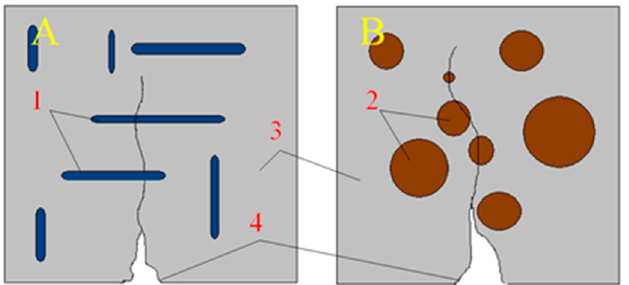
Figure 3. Scheme of the crack propagation and destruction of the middle part of the samples during the bending test of the composite: ( A ) crack propagation in a composite containing flat grains; ( B ) crack propagation in a composite containing round grains. Marks: 1—flat glass grains, 2—gravel grains, 3—binder resin, 4—propagating the crack. Flat grains located perpendicular to the propagating scratches are a kind of dispersed reinforcement improving the bending strength of the composite. In this process they are subject to stretching and protect against further crack propagation.